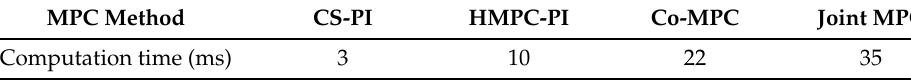
Table 5. Computation times of the four control